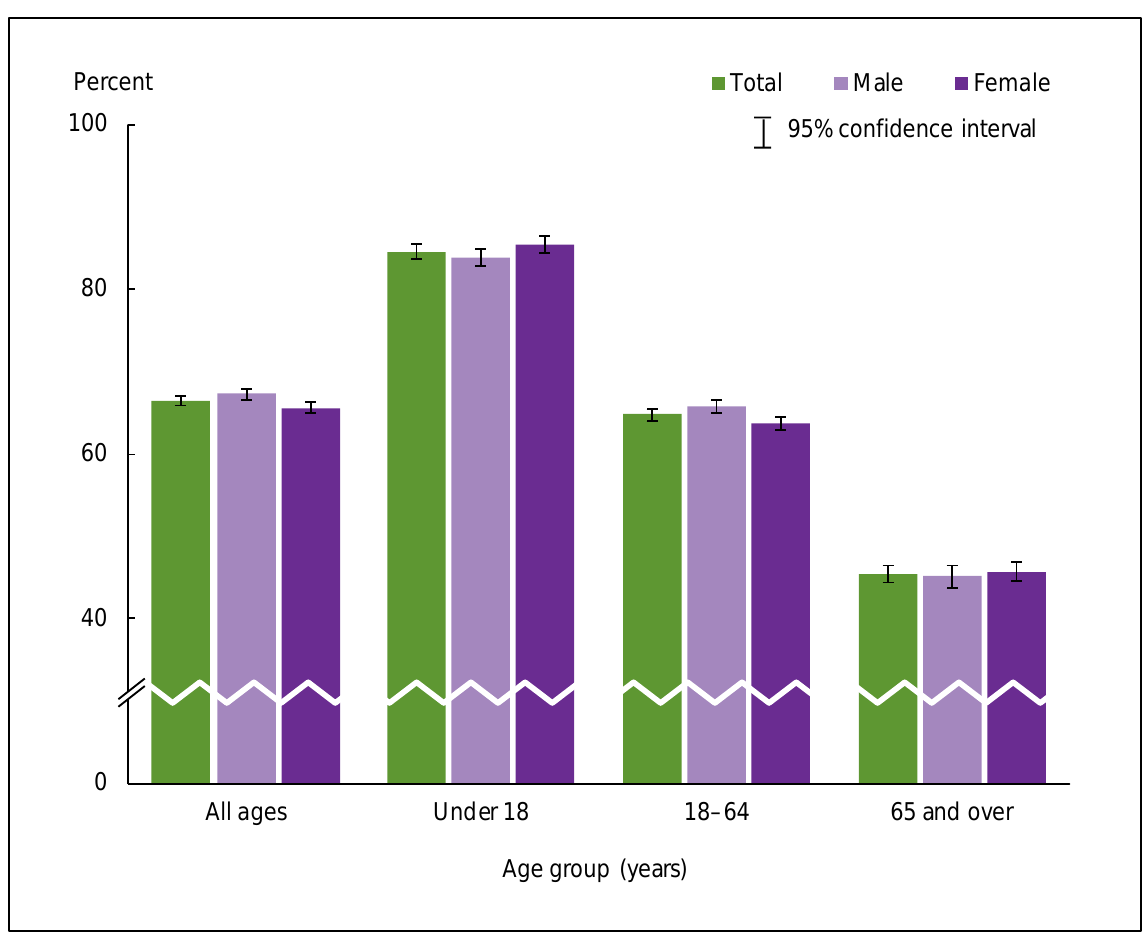
Figure 11.3. Percentage of persons of all ages who had excellent or very good health, by age group and sex: United States,